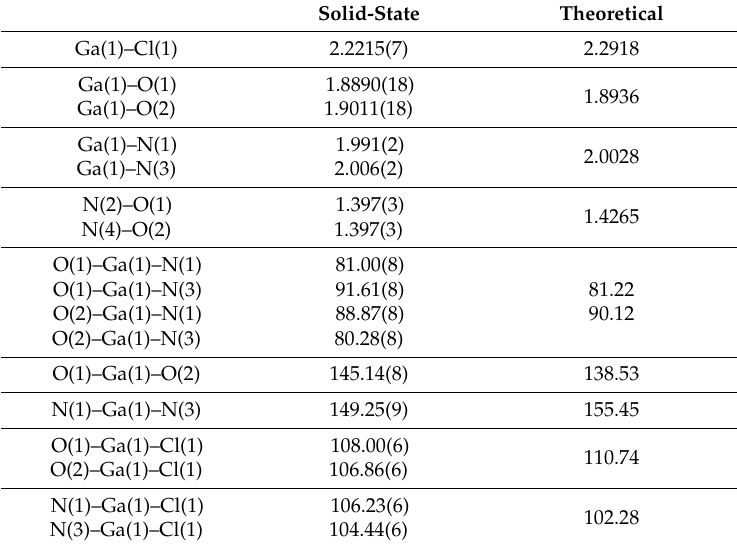
Table 1. Selected bond distances (Å) and angles ( ◦ ) the (pyNO − ) 2 GaCl complex obtained from the solid-state structure and theoretical